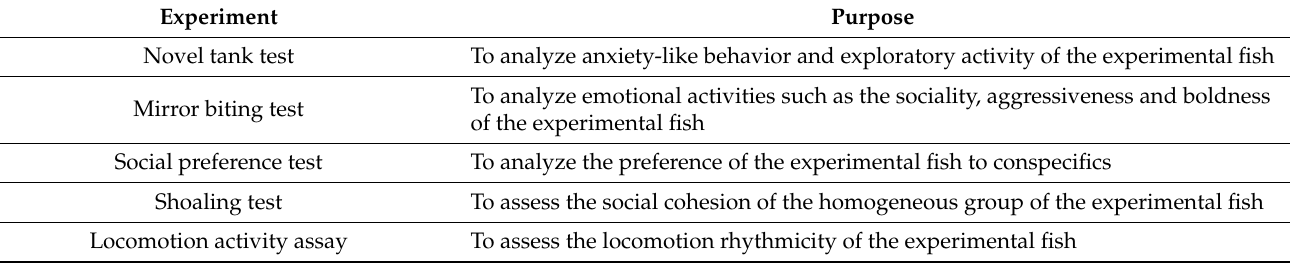
Table 1. A list of the behavioral assays and the purposes.